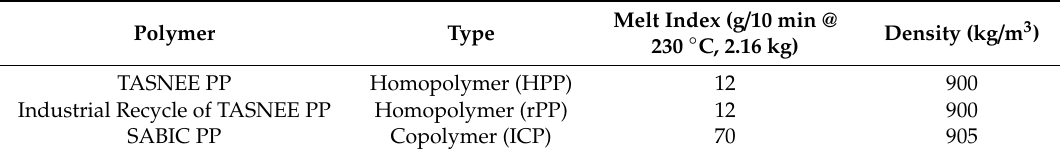
Table 1. Polymers used with melt index, density, and co-monomer types.